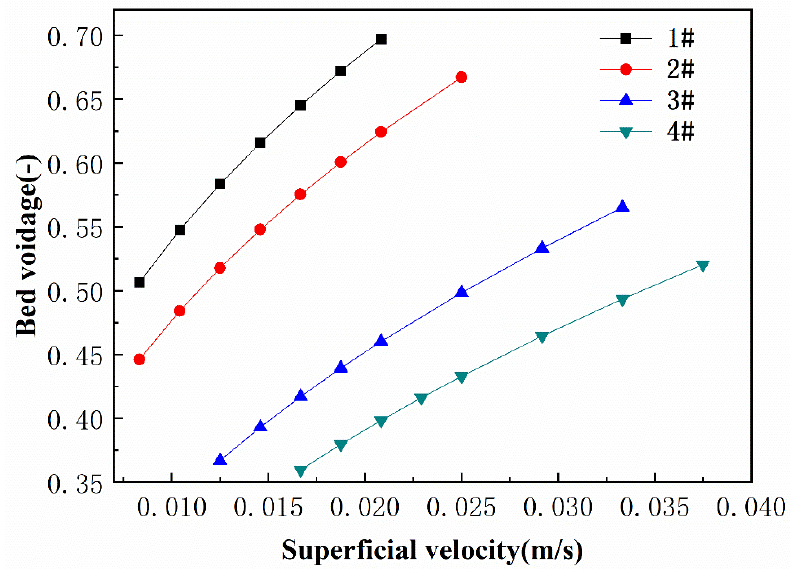
Figure 6. The relationship between bed voidage and superficial velocity.